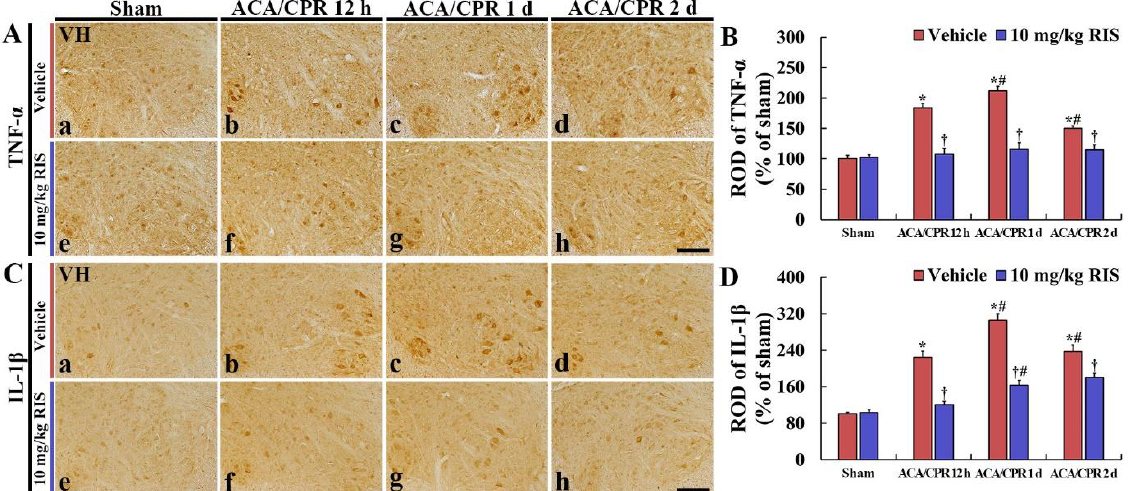
Figure 5. Immunohistochemical staining for TNF- α and IL-1 β ( A , C ) Immunohistochemistry for TNF- α ( A ) and IL-1 β ( C ) in the ventral horn of the Sham+vehicle ( a ), ACA/CPR+vehicle ( b – d ), Sham+RIS ( e ), and ACA/CPR+RIS ( f – h ) groups at 12 h, 1 day, and 2 days after ACA/CPR. In the ACA/CPR+vehicle group, TNF- α and IL-1 β immunoreactivities are significantly increased from 12 h after ACA/CPR. However, in the ACA/CPR+RIS group, immunoreactivities of TNF- α and IL-1 β are significantly low compared with that shown in the ACA/CPR+vehicle group. VH, ventral horn. Scale bar = 100 µ m. ( A , C ) RODs of TNF- α ( B ) and IL- 1β ( D ) immunoreactivity. The bars indicate the means ± SEM ( n = 7; * p < 0.05 vs. Sham+vehicle group; † p < 0.05 vs. ACA/CPR+vehicle group; # p < 0.05 vs. Pre-time point of corresponding group).